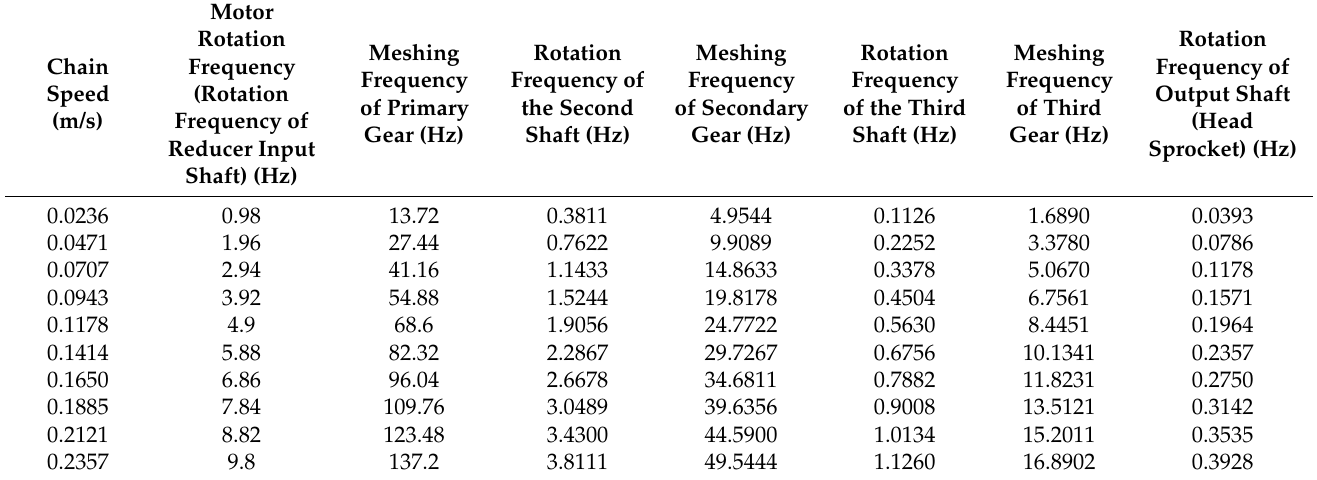
Table 5. Frequencies of various parts in the test